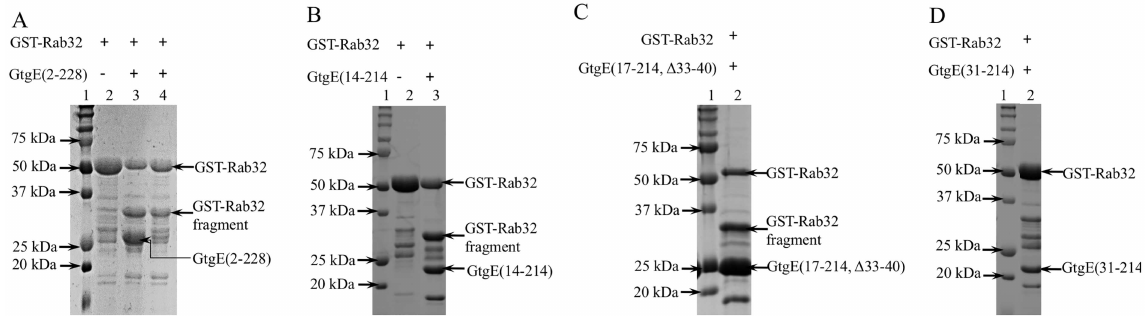
Fig 5. Superposition of GtgE (cyan) and papain (magenta). Papain structure used for the comparison has PDB code 3CVZ. (A ) Cleavageof GST-Rab32 by GtgE(2–228). Lane 1: protein markers, lane 2: GST-Rab32 fraction. The protein was only ~80% pure, other unidentified lower molecularweight bands were present in small amounts, lane 3: Cleavageof GST-Rab32 by GtgE(2– 228) mixed in 2:1 (substrate:enzyme) molar ratio, lane 4: As lane 2 but 20:1 ratio of Rab32:GtgE(2–228).(B) Cleavageof GST-Rab32 by GtgE(14–214), lane 1: protein markers, lane 2: partially purifiedGST-Rab32 fraction, lane 3: Cleavageof GST-Rab32 by GtgE(14–228) in 2:1 molar ratio. (C) Cleavageof GST-Rab32 by GtgE(17–214, Δ 33–40). Lane 1: protein marker,s lane 2: Cleavageof GST-Rab32 by GtgE(17–214, Δ 33–40)in 2:1 molar ratio; D) GST-Rab32 in the presencefo GtgE(31–214). Lane 1: protein marker, lane 2: GST-Rab32 and GtgE(31–214) in 2:1 molar ratio. The unmarkedbandswere present in partially purified GST-Rab32 (see panel B lane 2), no band corresponding to the GST-Rab32 degradationproduct was